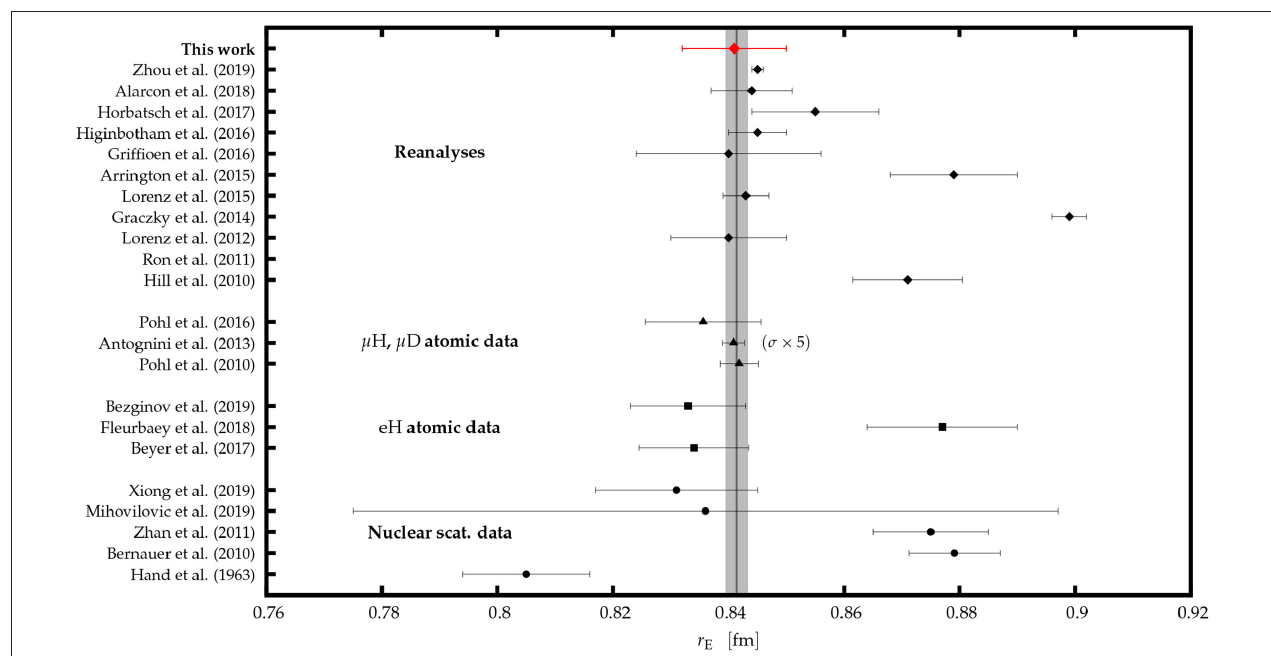
FIGURE 6 | The result of this work compared to other extractions of the proton charge radius. Full circles show findings of modern nuclear scattering experiments [11, 32–34] together with the original result of Hand et al. [2]. Full squares represent values obtained from the recent atomic hydrogen spectroscopy measurements [9, 10, 12]. The triangles denote values determined from the muonic hydrogen (deuterium) measurements [6, 7, 35]. The uncertainties of data from Pohl et al. and Antognini et al. are multiplied by factor 5 for clarity. The diamonds show recent reanalyses of the electron scattering experiments [14, 15, 17–20, 36–40]. The gray line with the corresponding band is the recommended value (CODATA 2018, [